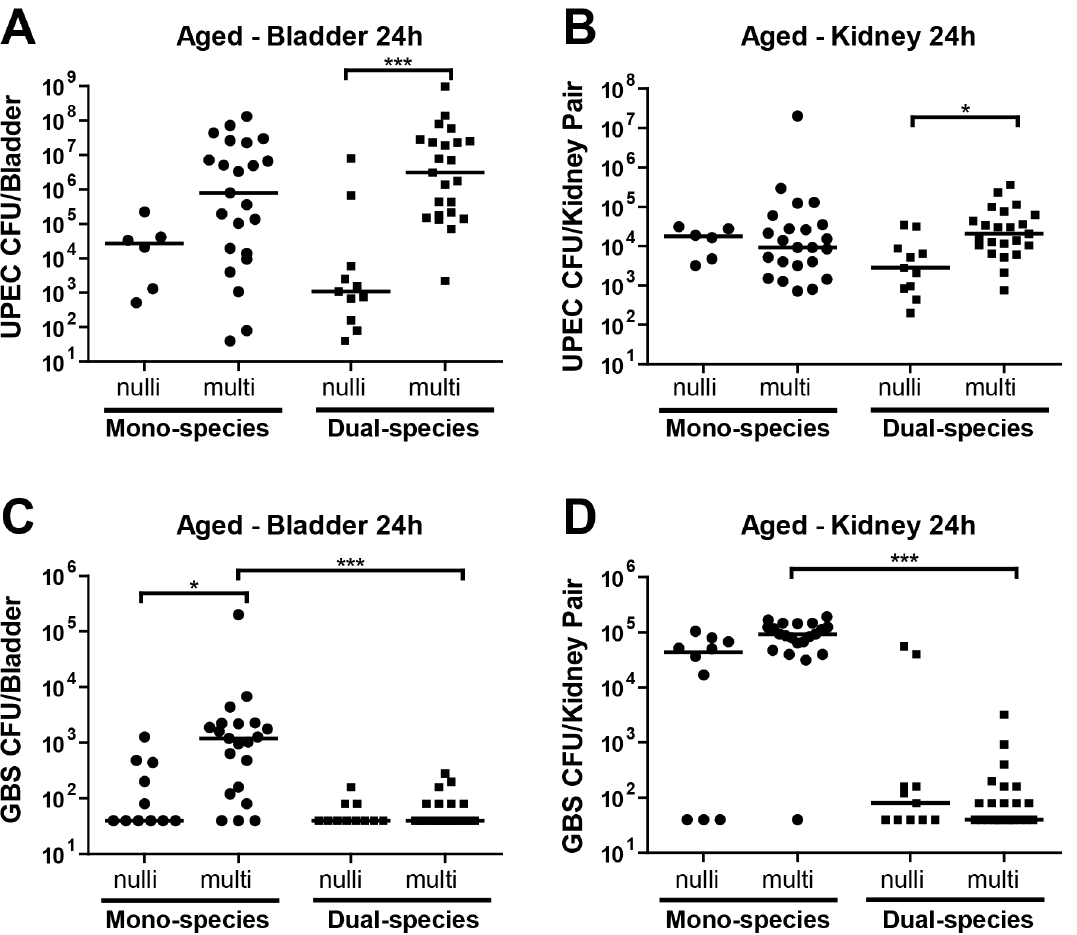
Figure 2. Parity-associated risk factors for UTI in aged hosts. Bladder CFU for UPEC ( A ) and GBS ( C ), and kidney CFU for UPEC ( B ) and GBS ( D ) at 24 hours post infection of C3H/HeN female mice with , 10 7 UPEC UTI89 alone or with , 10 7 GBS COH1 in UPEC + GBS mixed inoculation. N=1–4, at least 5 mice per experiment, as described for Fig. 1. Data from 7–11 mo (aged) nulliparous animals are replotted from Fig. 1 here for ease of comparison with data from aged multiparous hosts. The horizontal bar represents the median value for each group of mice. Statistical significance was determined by the Kruskal-Wallis test with Dunn’s post-test for multiple comparisons. * P , 0.05, *** P , 0.0005.